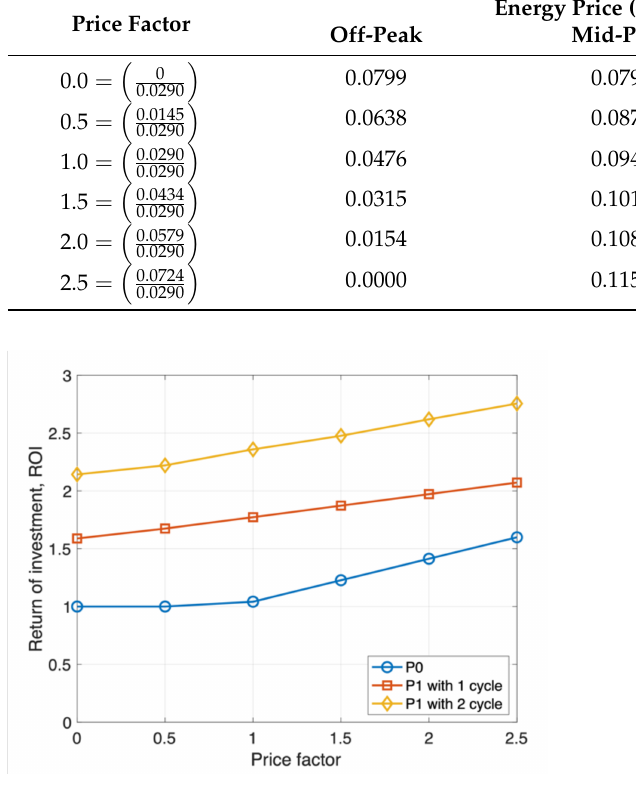
Figure 8. Return of investment of participants with varying the price